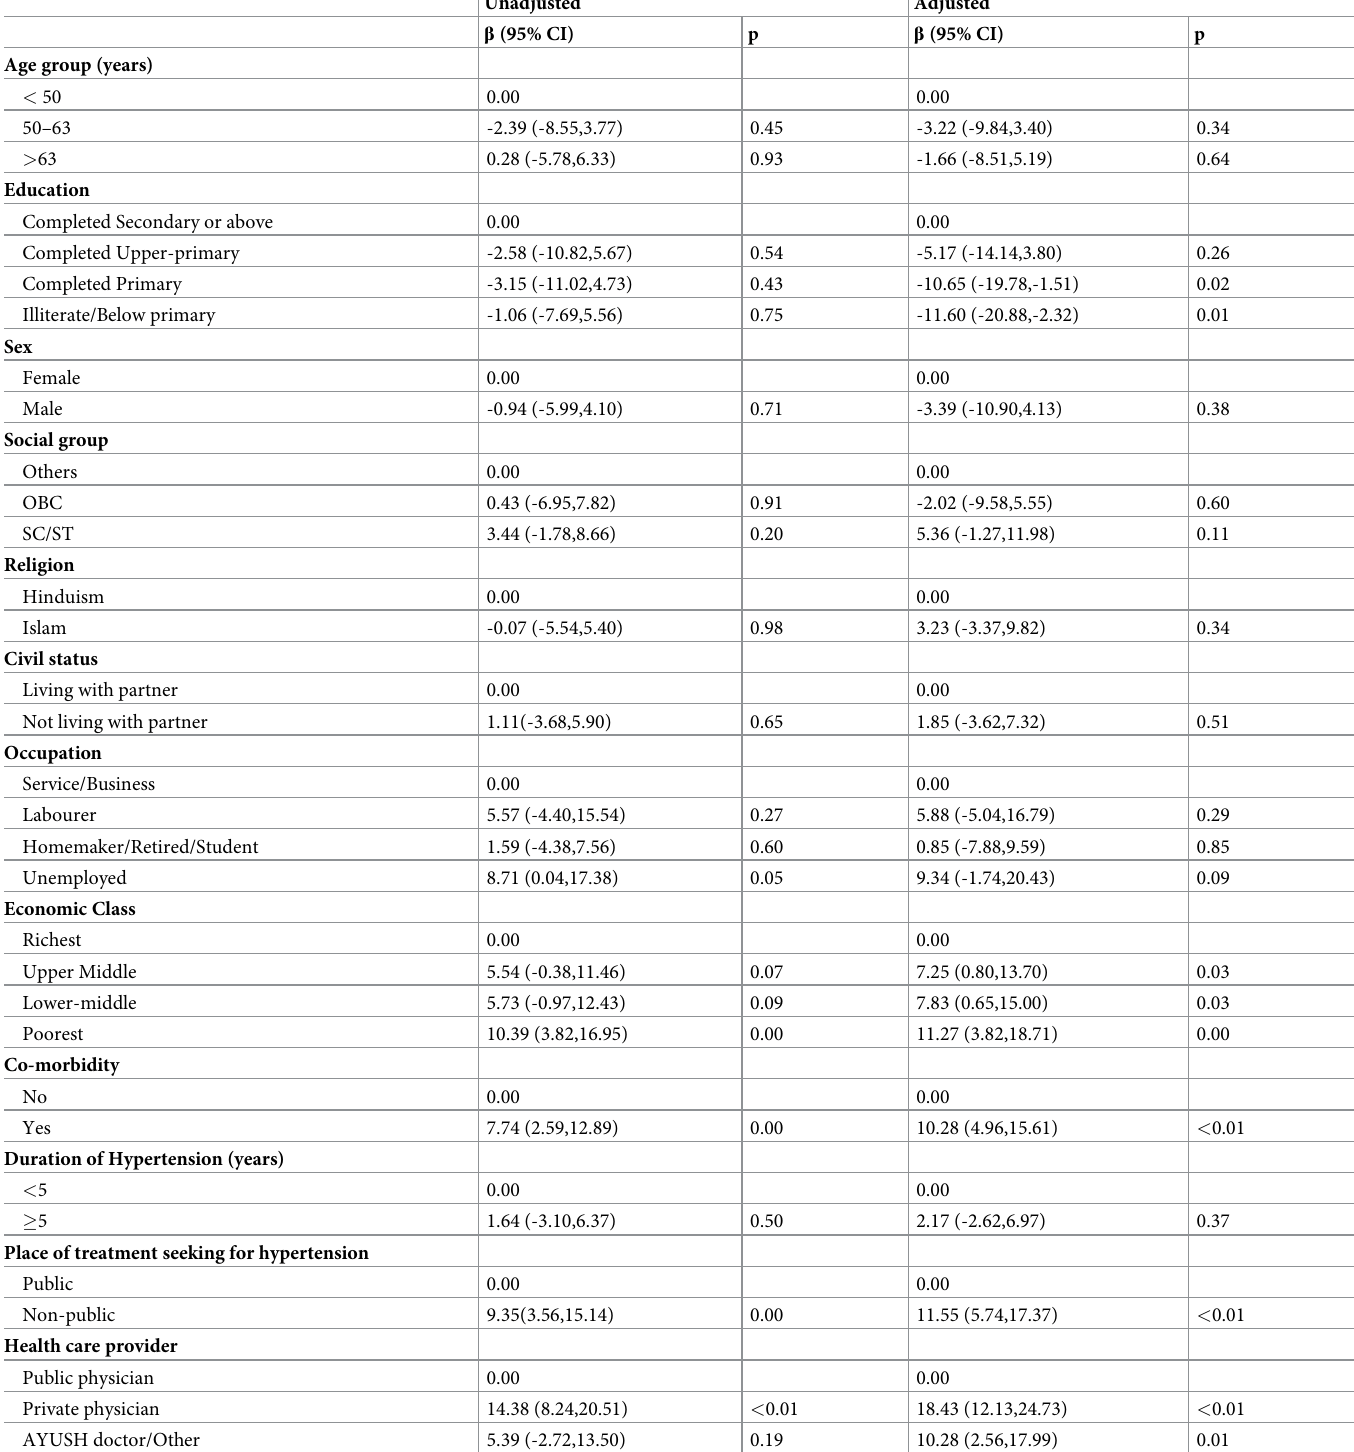
Table 3. Factors associated with relative expenditure: Linear regression with